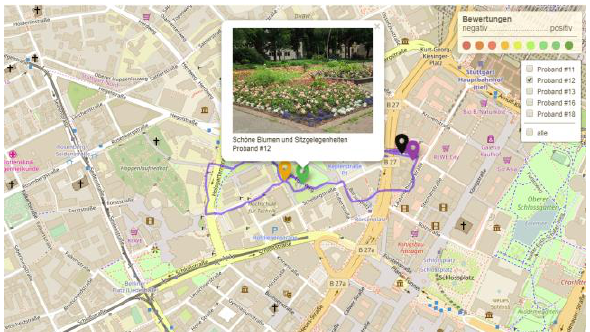
Figure 2. Screenshot of the